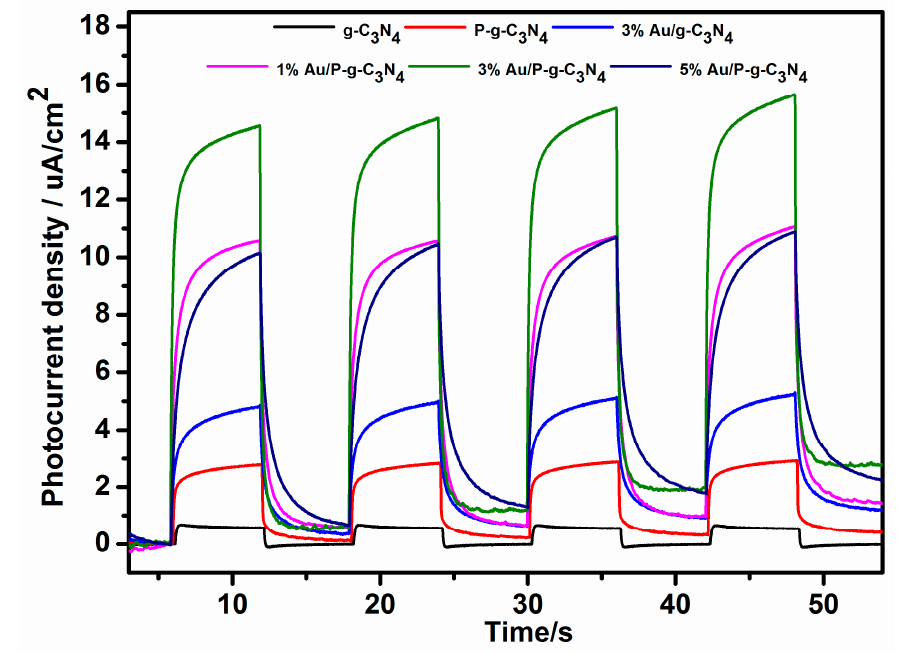
Figure 7. Transient photocurrent density of obtained samples.